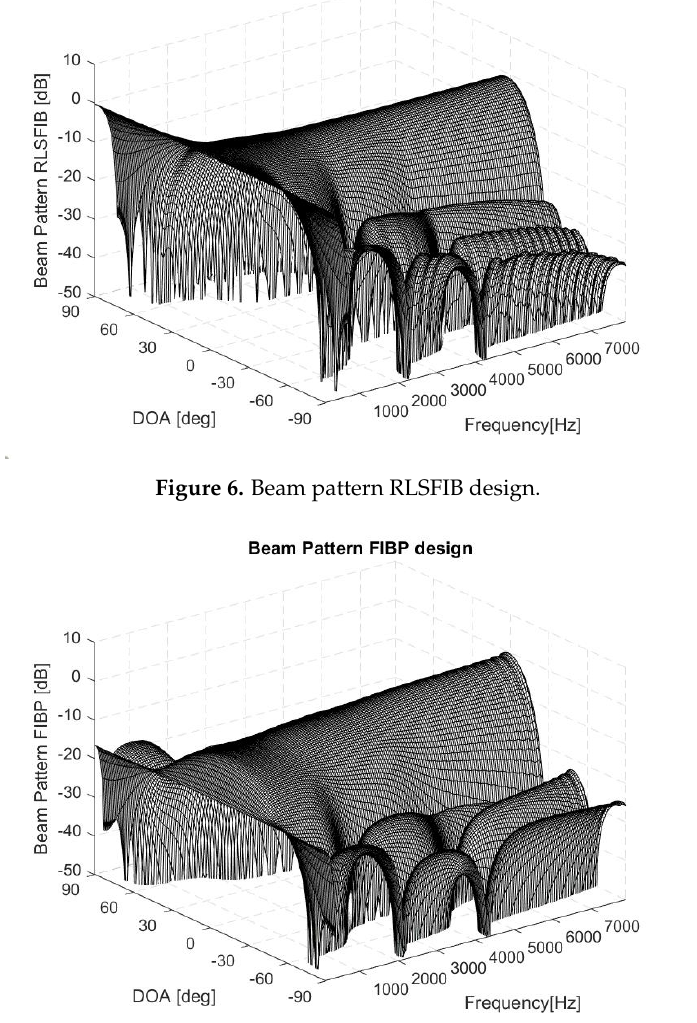
Figure 7. Beam pattern FIBP